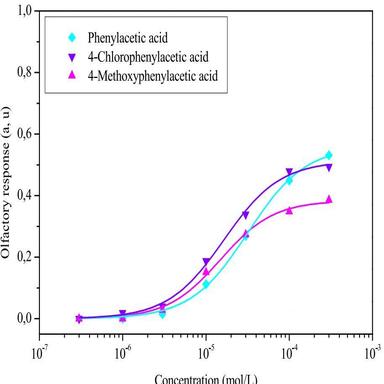
Adjusted experimental dose-olfactory response curves of phenylacetic acid, 4-chlorophenylacetic acid, and 4-methoxyphenylacetic acid pheromones on the Zebrafish ORA1 with the selected model (illustrated by straight line).